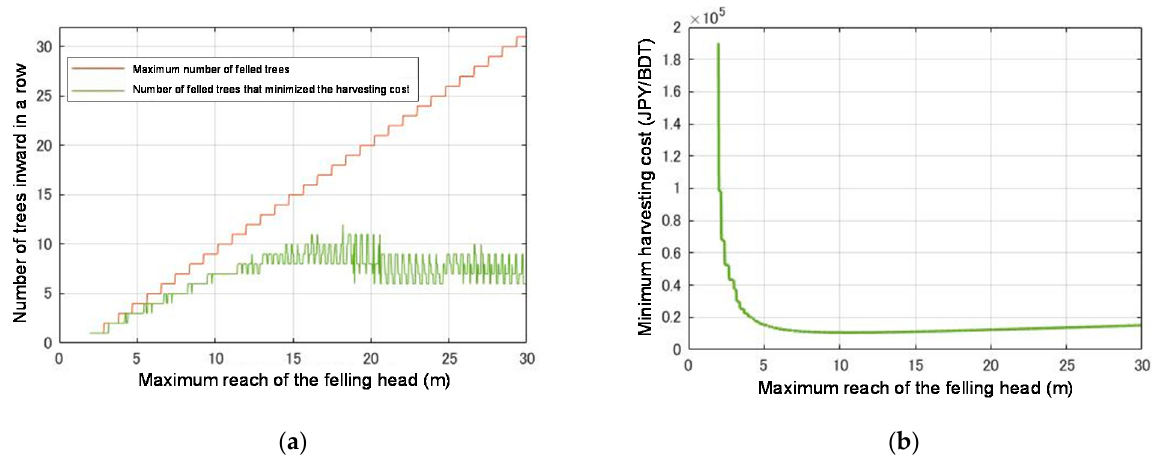
Figure 7. Two factors were examined in the case where the length of the maximum reach of a felling head was varied: ( a ) Maximum number of felled trees inward in a row that would minimize harvesting cost; ( b ) Minimum harvesting cost itself.